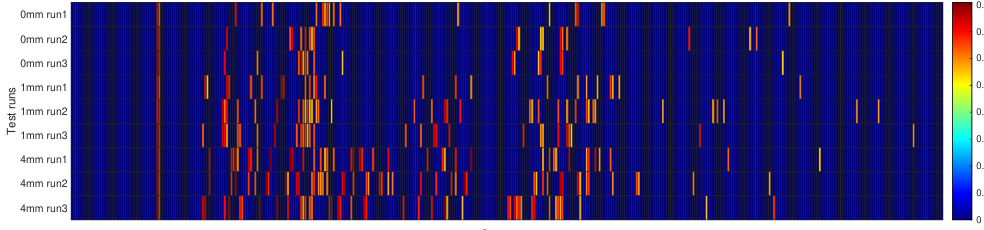
Figure 13. Anomaly scores above the 88th percentile threshold for all test